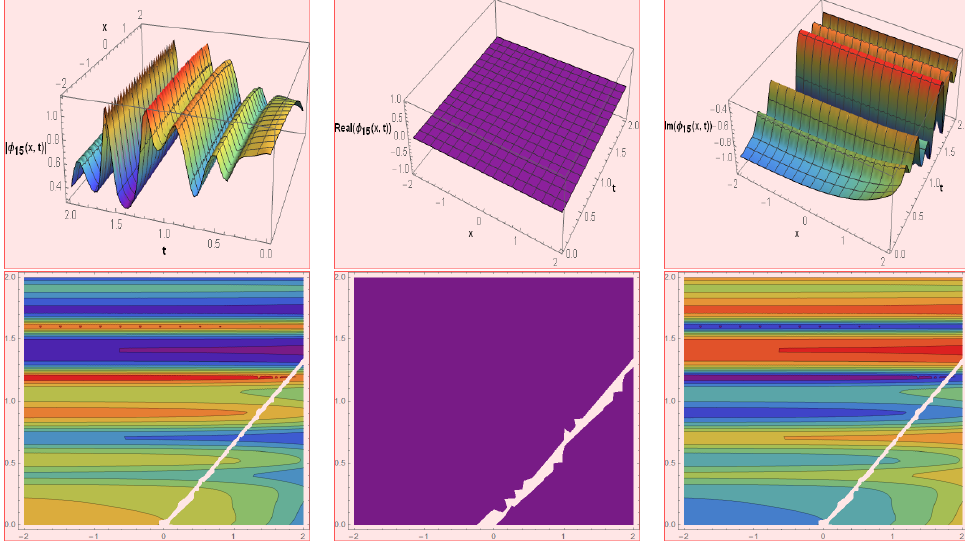
Figure 8. The absolute, real, and imaginary behavior in the shape of 3D and their corresponding contour plots are dispatched for φ 15 ( x , t )